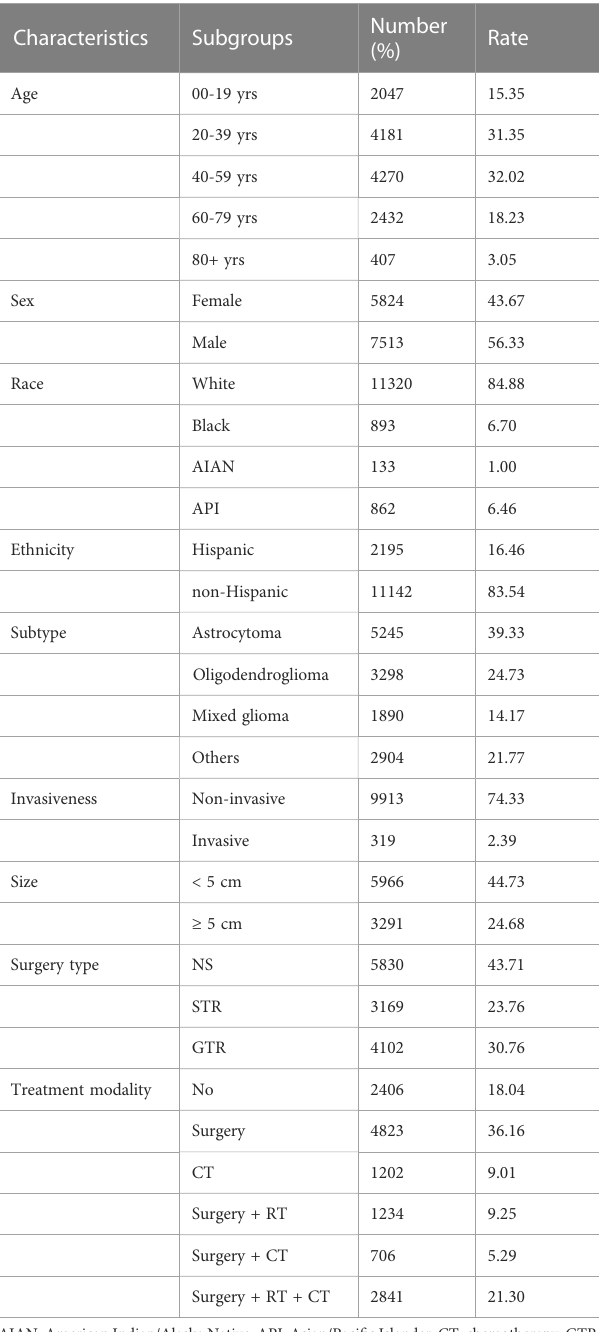
(Supplementary Figure 1). To further optimize survival analysis and avoid the limitations of overall survival, a competing risk regression model was used to perform LGG-speci fi c survival analysis. At data collection, 4759 patients with LGG (35.7%) died of their gliomas. When we compared the cumulative incidence of deaths from LGGs with all-cause mortality, the data demonstrated a signi fi cant difference ( P < 0.0001, Figure 2A). Additionally, the cumulative risk of mortality from LGG was 14.6% (95% CI: 10.6%-14.3%),